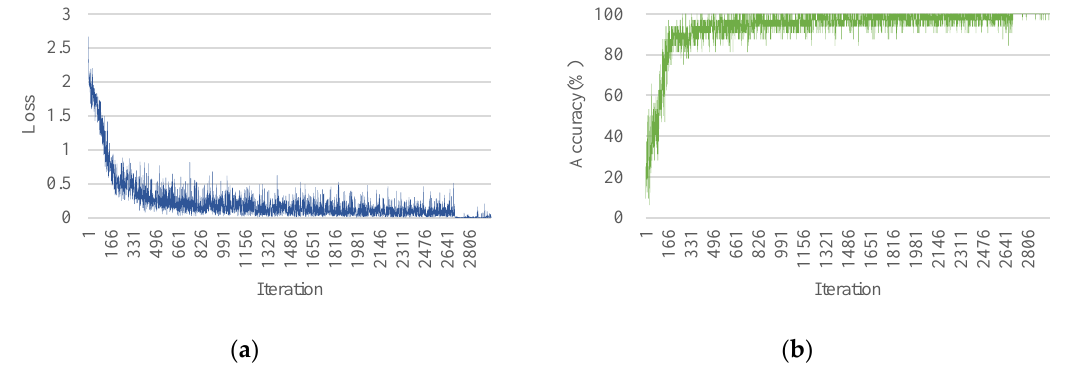
Figure 7. CNN training results: ( a ) The blue line shows the loss value of trained CNN; ( b ) The green line shows the accuracy of trained CNN.